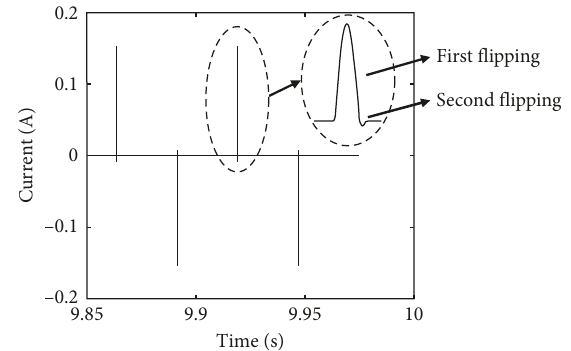
Figure 7: Inductor current waveform with the SP-OSSHI